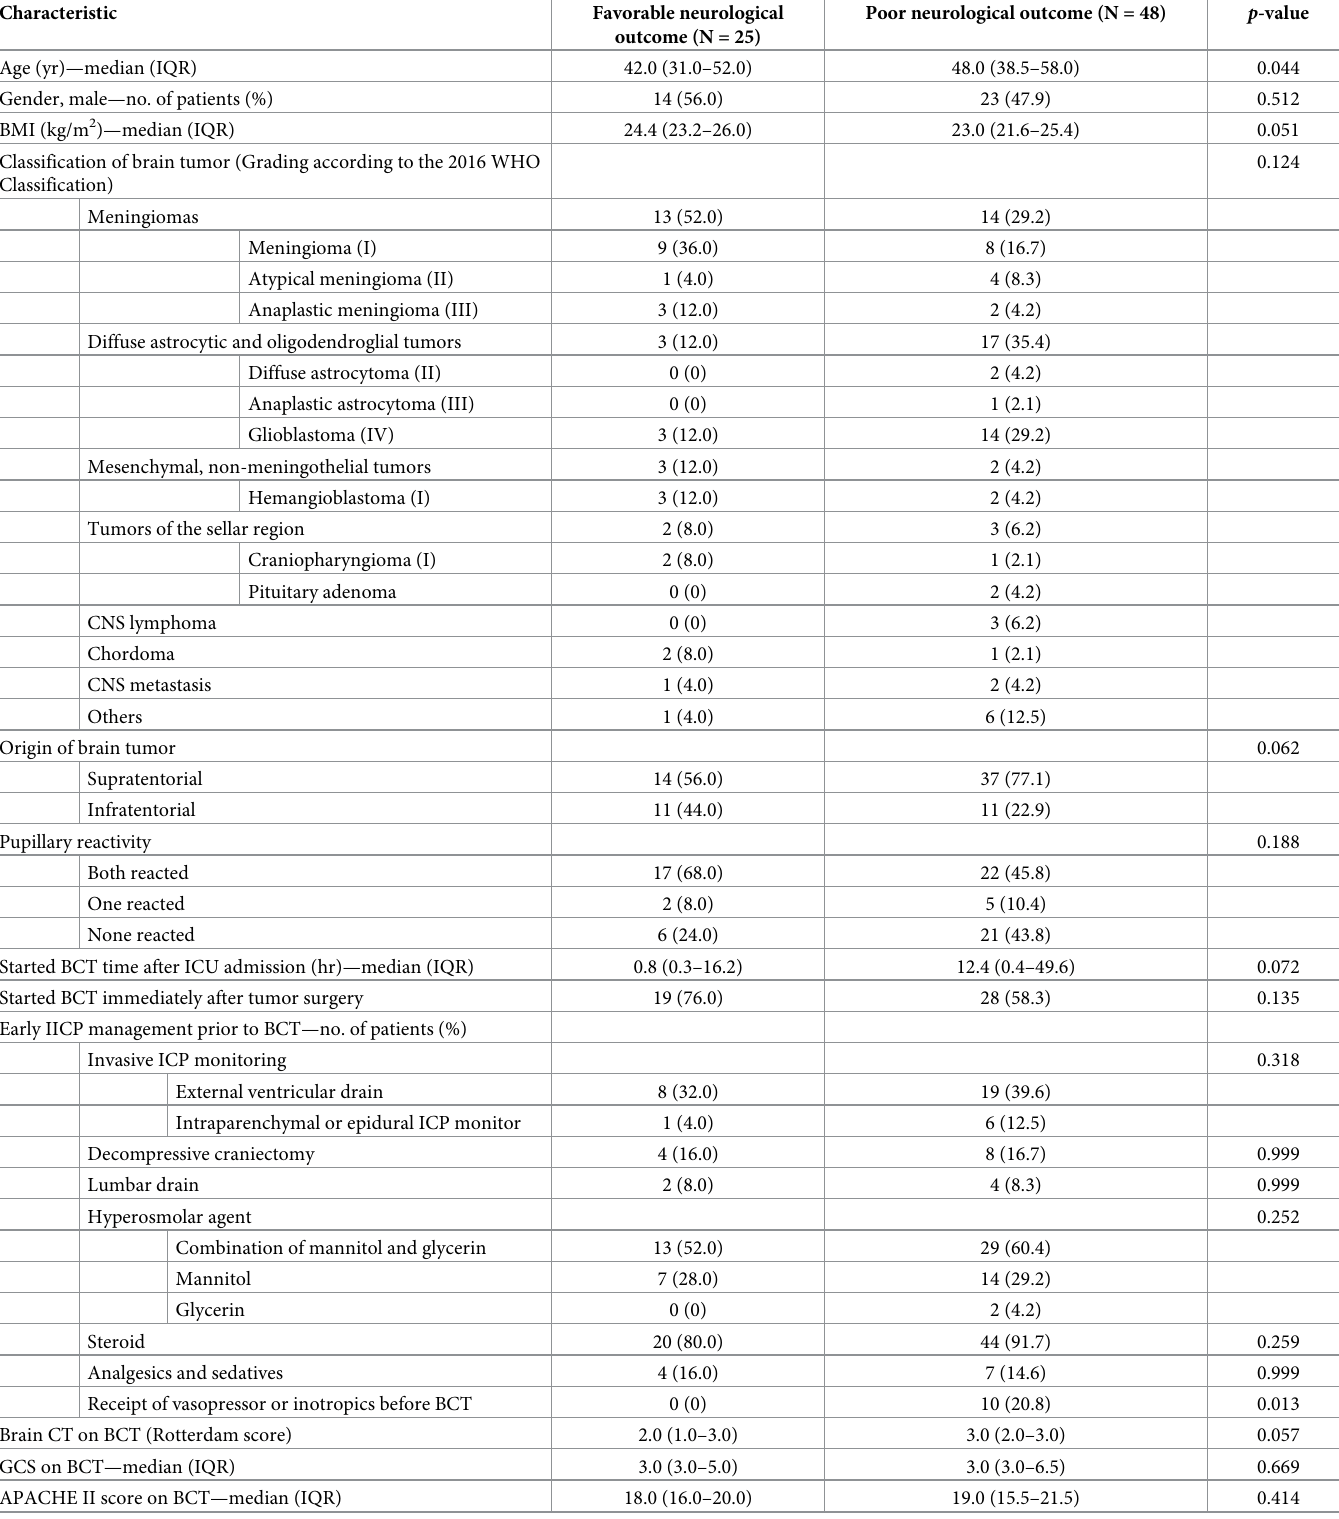
Table 1. Baseline characteristics of barbiturate coma